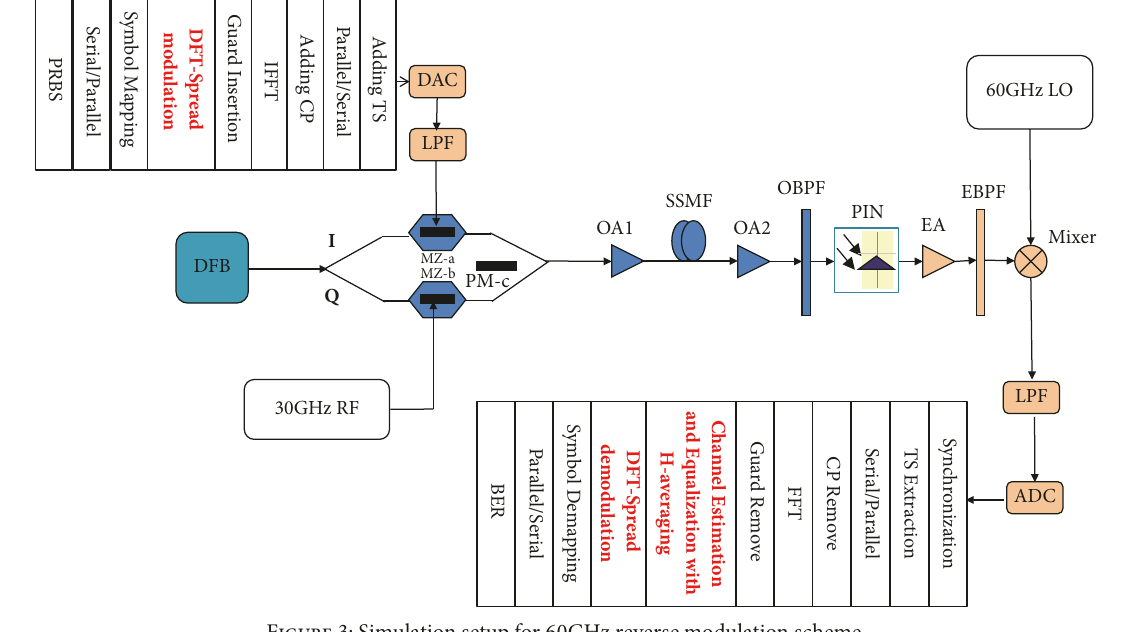
Figure 3: Simulation setup for 60GHz reverse modulation scheme.